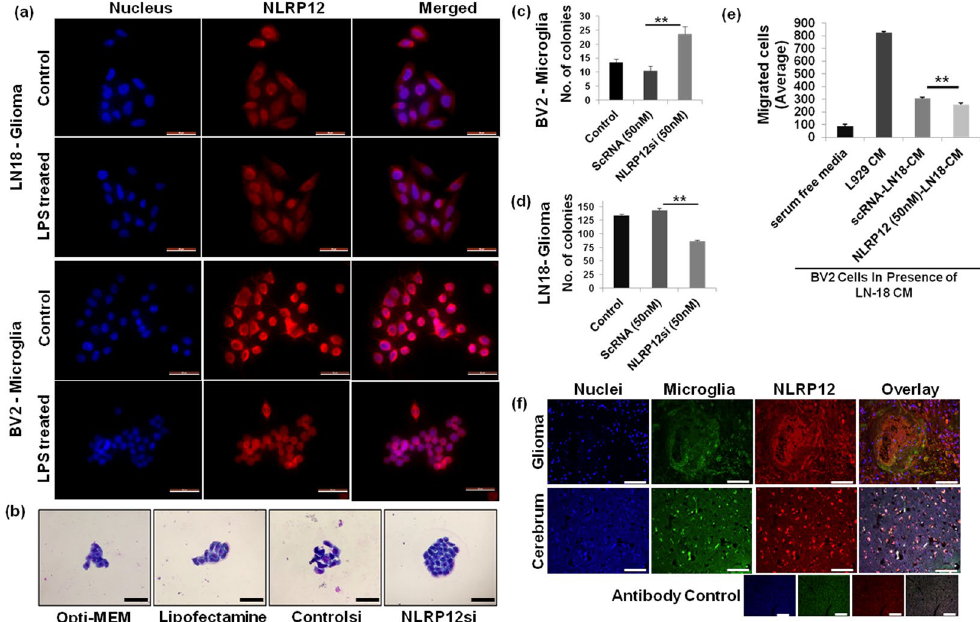
Figure 7. NLRP12 inhibition regulates cellular proliferation. ( a ) NLRP12 expression was observed in glioma (LN18) and microglial (BV2) cells using immunofluorescence (magnification: 40X, scale bar: 50 μ m). ( b ) Colony formation assay shows increased cellular proliferation in the NLRP12si treated microglia. Magnification: 40X. ( c , d ) Quantification of both BV2 and LN18 cells per colony. ( e ) Effect of LN18 (NLRP12 siRNA treated) cell conditioned medium (CM) on BV2 cell migration was assessed using migration assay. 8 image sections per sample were quantified for migration analysis. Student’s t-test and one-way AVOVA were performed to find the statistical significance of colony formation and migration assay respectively (p-value; * < 0.05, ** < 0.005). The error bar indicates standard error of mean. ( f ) NLRP12 expression in human normal brain tissue and glioma sections, using anti-NLRP12 antibody (N = 7). Nuclei were stained blue with DAPI and microglia were stained green with FITC tagged lectin RCA (Ricinus Communis Agglutinin-1); Magnification: 20X, scale bar: 100 µ